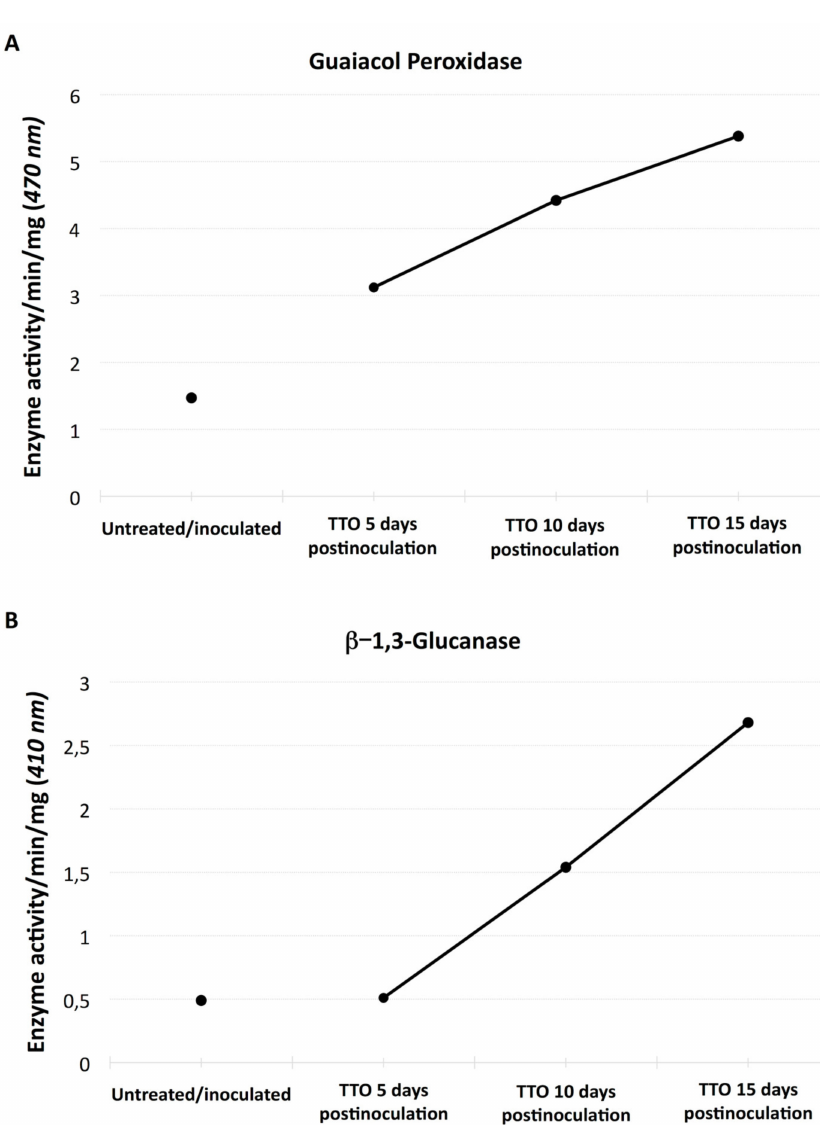
Figure 2. E ff ect of foliar applications of TTO on young banana plants in the activities of guaiacol-peroxidase ( A ) and B-1,3-glucanase ( B